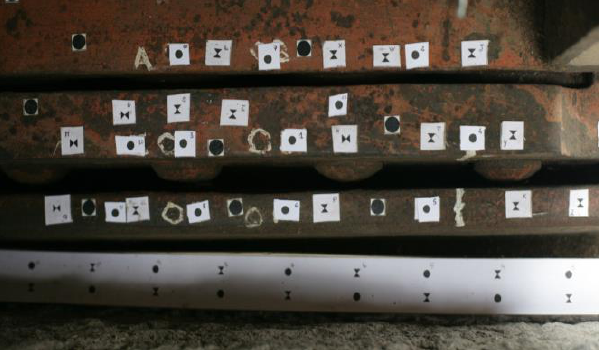
Figure 10. Frame with control points and tie Ponts disposed on